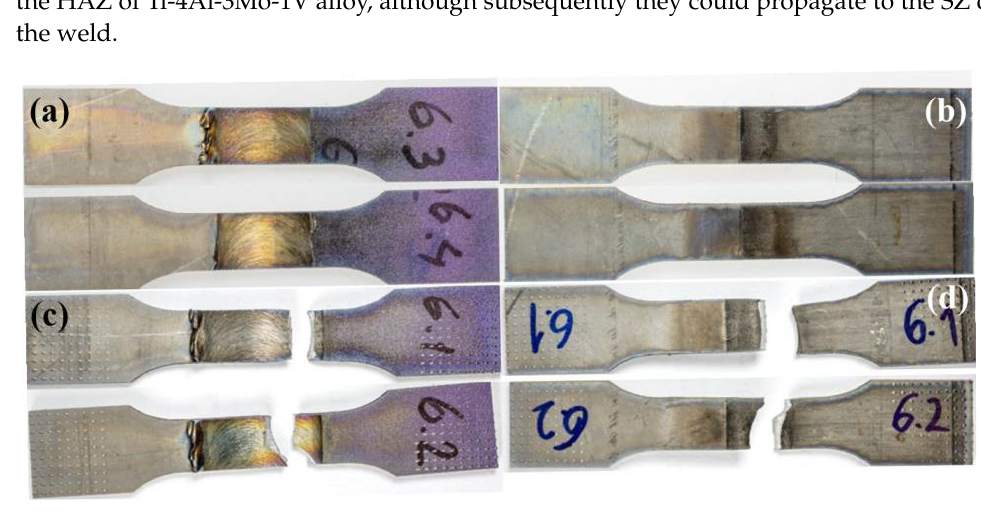
Figure 9. FSW joint tensile specimens of Ti-4Al-3Mo-1V/Ti-6Al-4V titanium alloys: top ( a ) and bottom view before testing ( b ), and top ( c ) and bottom view after testing ( d ). SEM images of the fracture surfaces of Ti-4Al-3Mo-1V/Ti-6Al-4V alloy joints are pre-